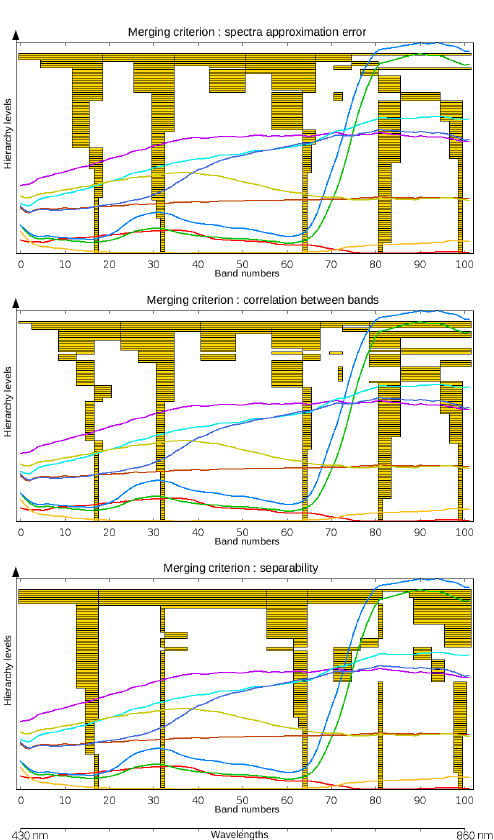
Figure 5: Pavia data set: selected bands at the different levels of the hierarchy using the greedy approach for hierarchies of merged bands obtained using different band merging criteria : spectra piece-wise approximation error (top), between band correlation (middle), class separability (bottom). x-axis corresponds to the band numbers/wavelengths. y-axis corresponds to the level in the band merging hierarchy (bottom : finest level with original bands, top : only a single merged band).